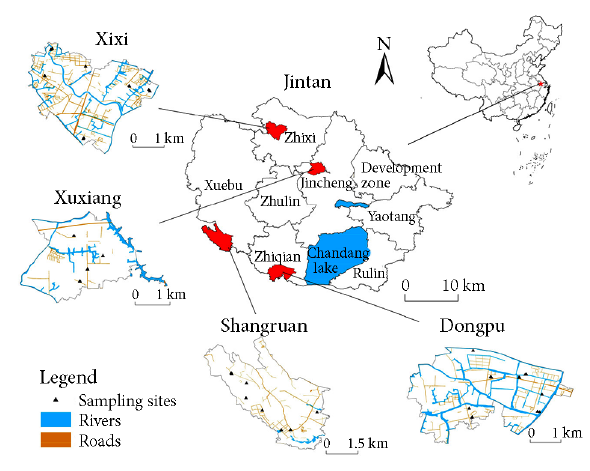
Figure 1. The study area and sampling